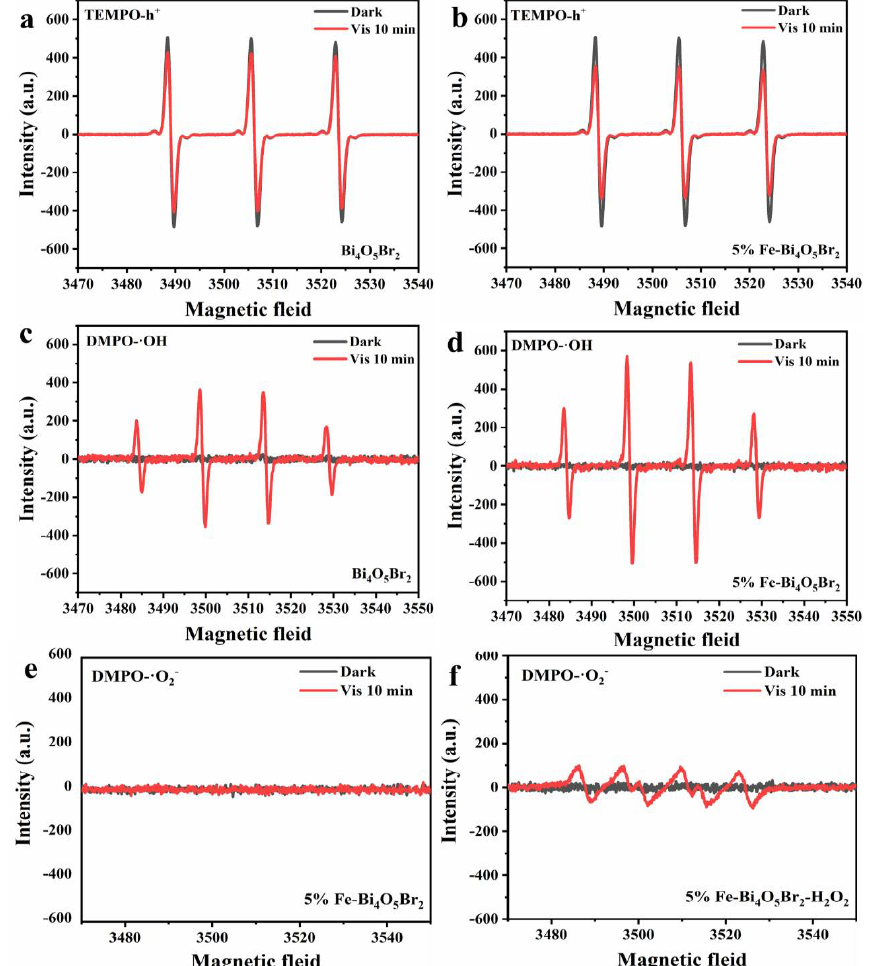
Figure 8. The in-situ ESR spectra of Bi 4 O 5 Br 2 and 5%Fe-Bi 4 O 5 Br 2 . ( a , b ) h + spectra of Bi 4 O 5 Br 2 and 5%Fe-Bi 4 O 5 Br 2 using TEMPO in water, ( c , d ) • OH spectra of Bi 4 O 5 Br 2 and 5%Fe-Bi 4 O 5 Br 2 by adding DMPO and H 2 O 2 in water and ( e , f ) • O 2 − spectra of 5%Fe-Bi 4 O 5 Br 2 by adding DMPO and H 2 O 2 in